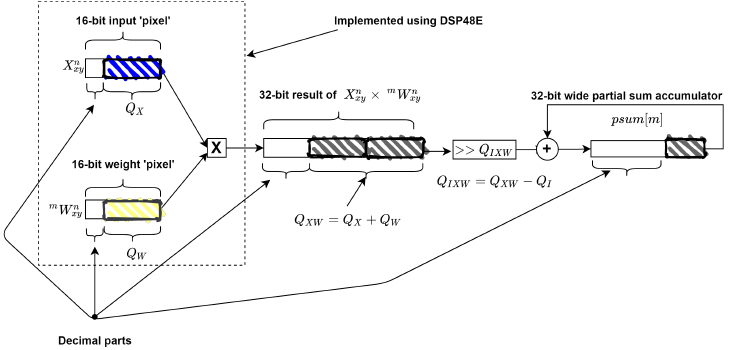
Figure 9. Convolution processing element and its working procedure.